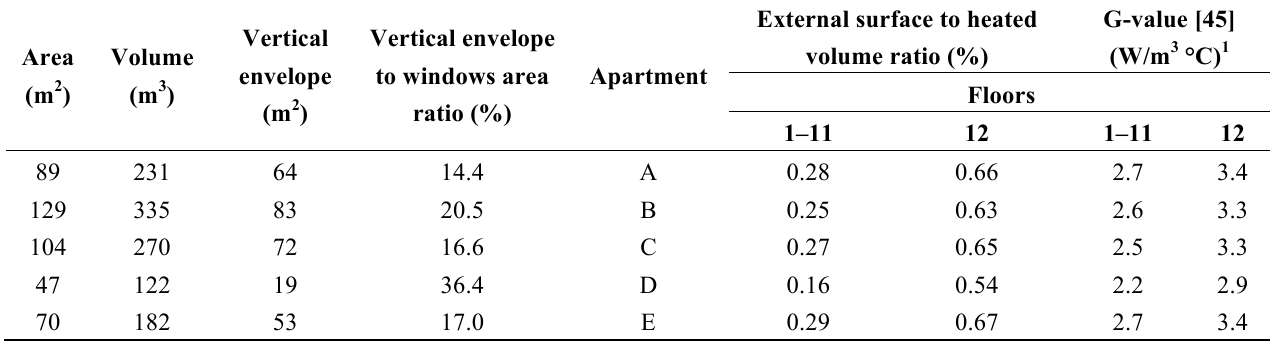
Table 2. Some dimensional and energetic